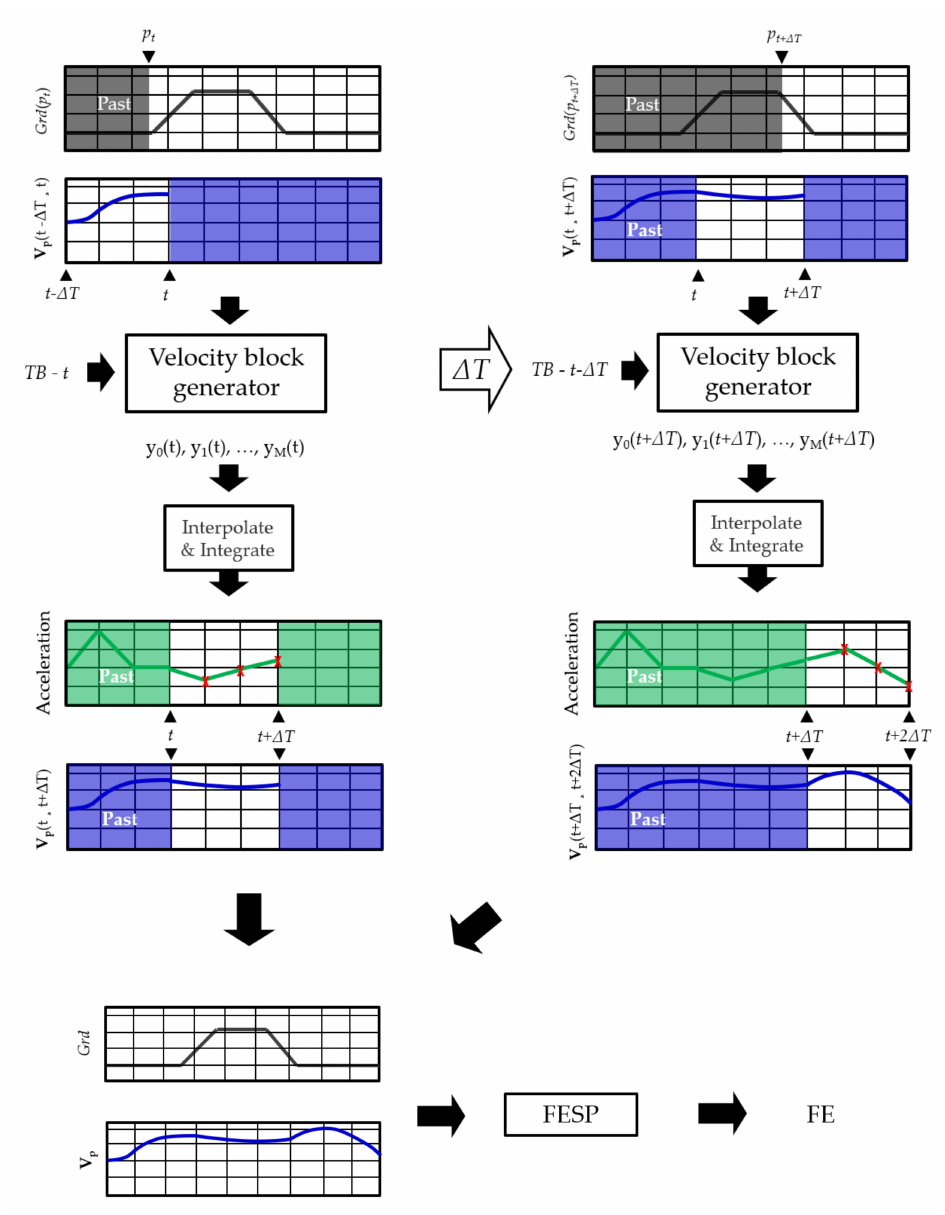
Figure 6. The DNN, which is the velocity block generator, takes the state by direct inputs and by its hidden state in long short-term memory (LSTM) layers. Its output will generate accelerations and velocities, V p ( t , t + ∆ T ). These velocity blocks make the whole V p for the trip. The fuel consumption simulation program takes this V p along with Grd to calculate the fuel